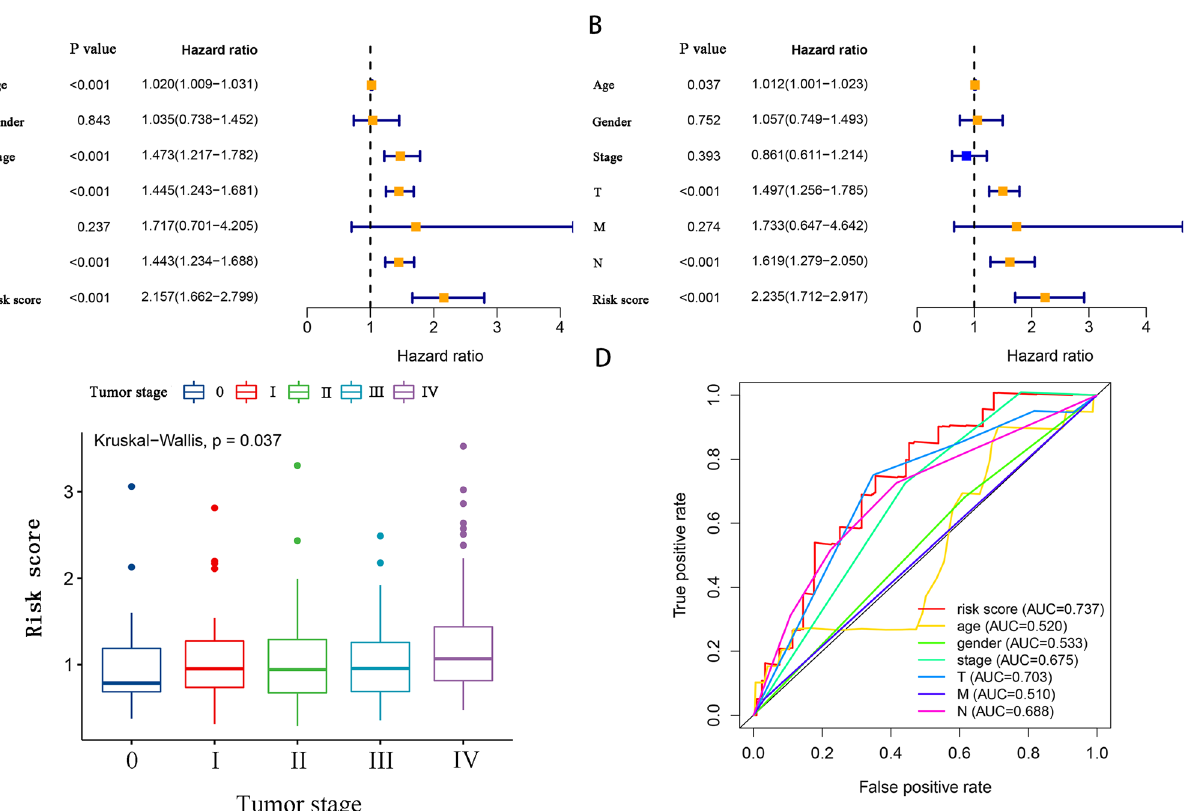
Figure 5. Relationship between prognostic prediction models and clinical factors in melanoma patients. ( A ) Univariate Cox analysis of clinical features based on the training cohort. ( B ) Multivariate Cox analysis of clinical features based on the training cohort. ( C ) Association between risk scores and clinical features of patients with melanoma. ( D ) ROC curves for risk scores and clinical factors. Clinical factors include age, gender, tumor stage, N (lymph node metastasis), T (tumor size), and M (distant